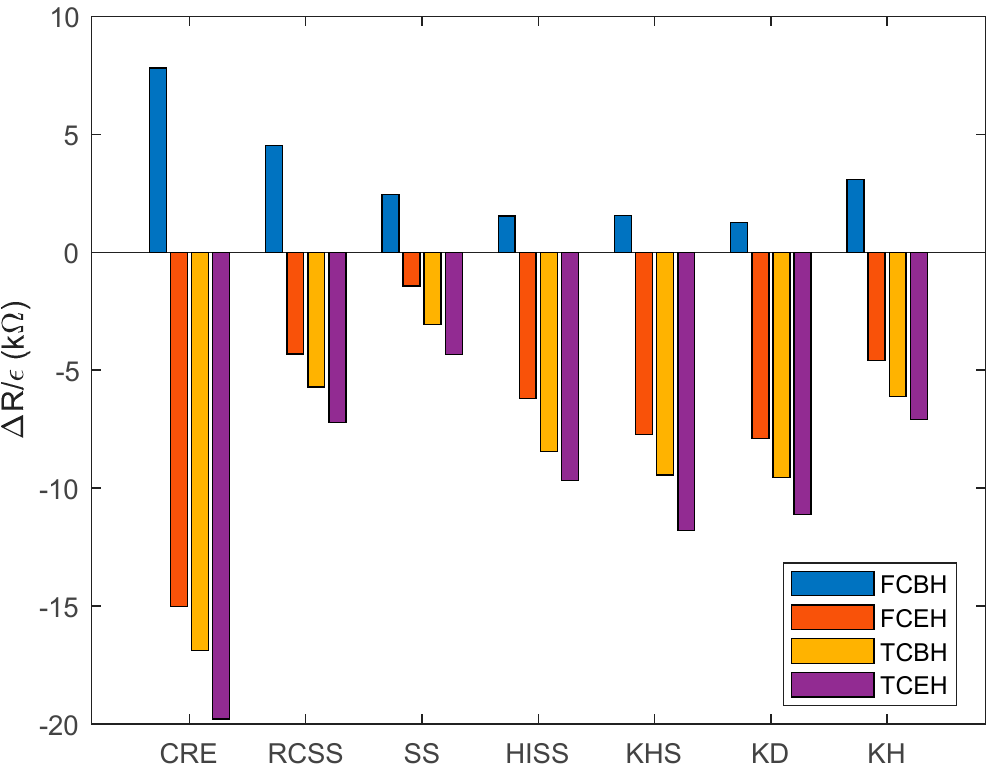
Figure 19. Values of resistance change over strain are provided for each structure. FCBH: first cycle before halfway; FCEH: first cycle end of halfway; TCBH: tenth cycle before halfway; TCEH: tenth cycle end of halfway.